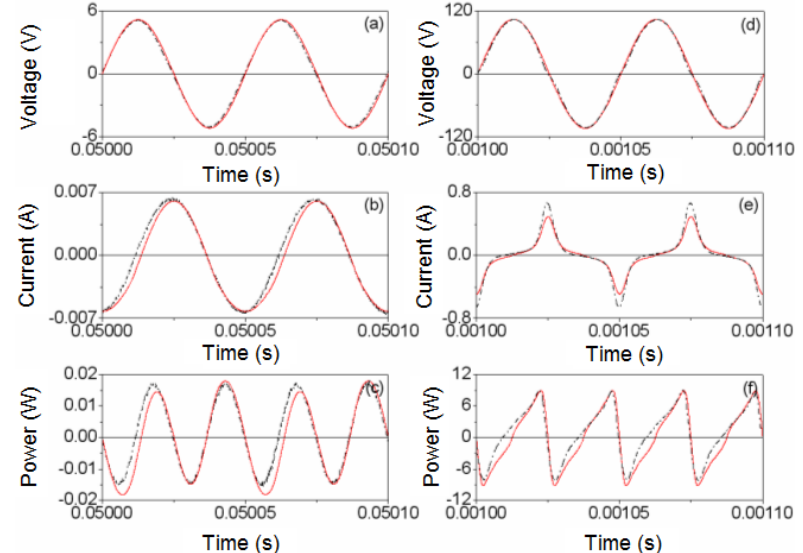
≈ 104.75 V and time step  = 2  10 −8 p